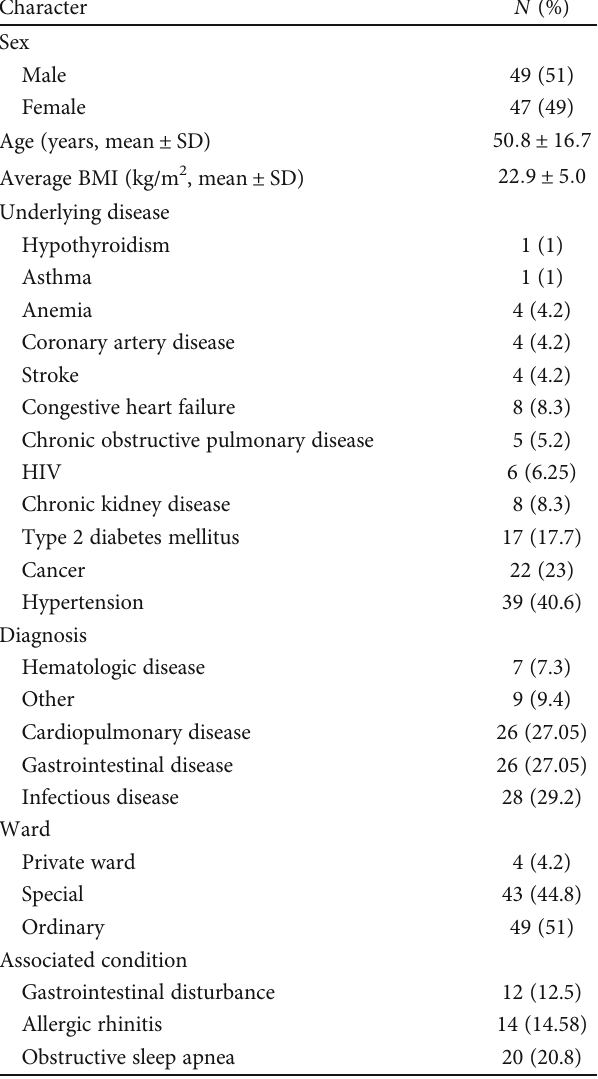
Table 1: Baseline clinical